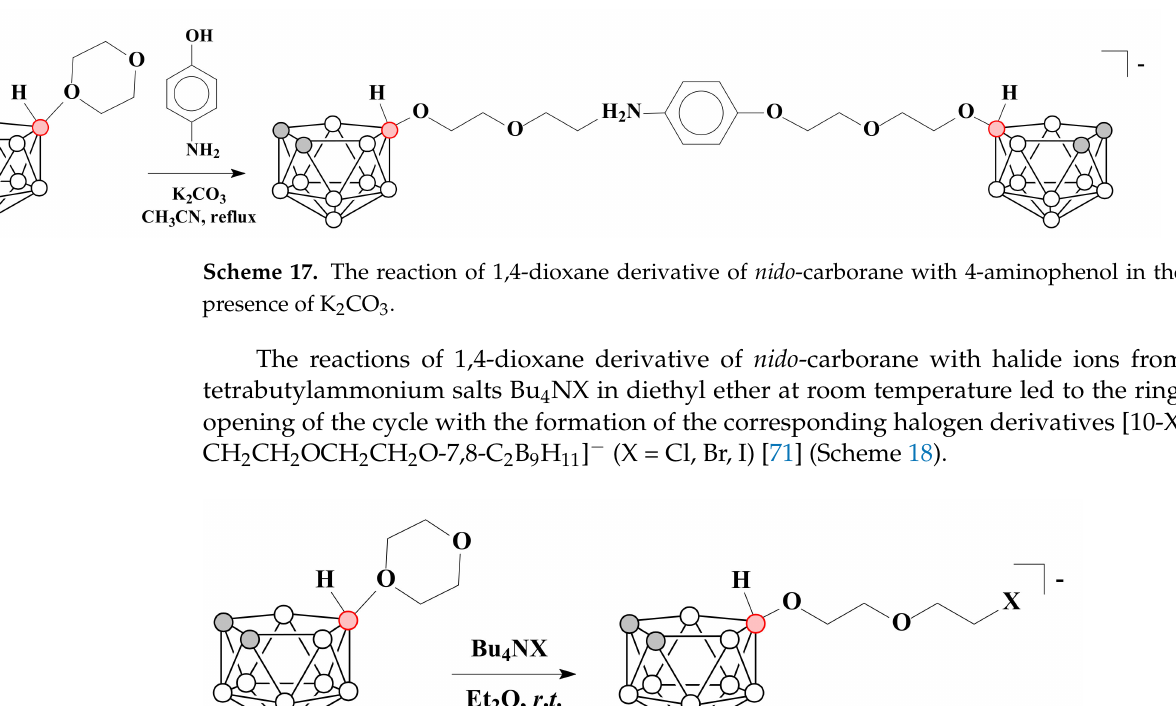
Scheme 16. The ring-open reactions of 1,4-dioxane derivative of nido -carborane with primary amines.